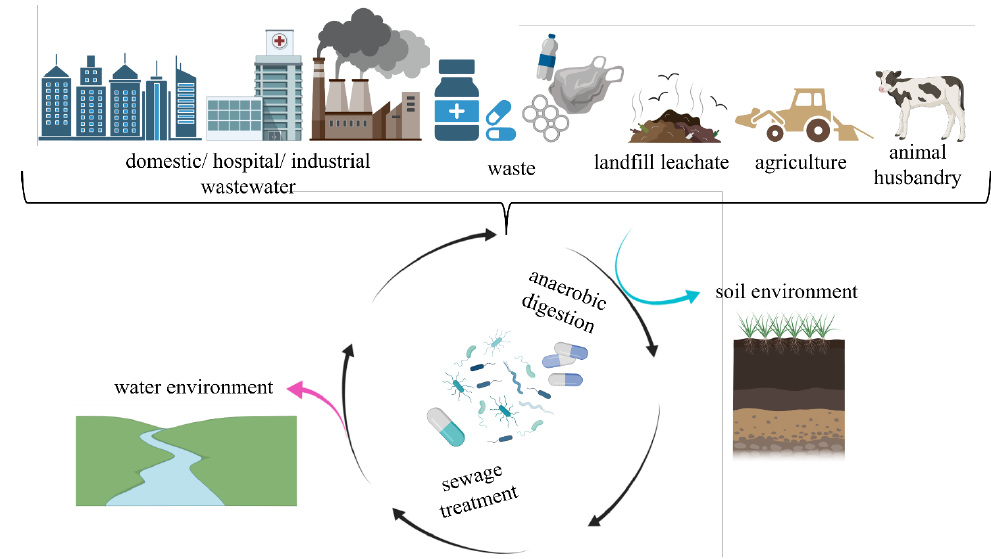
Figure 2. The potential origin and fate of ARGs in the